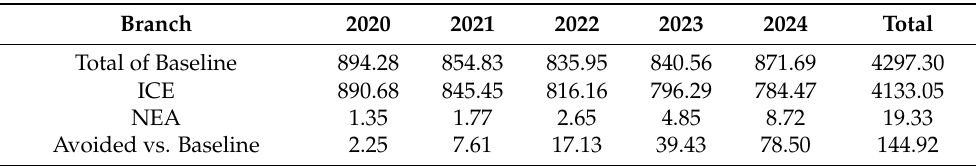
Table 10. Table of differences between the carbon emissions of the transport module in the traffic improvement scenario and the baseline